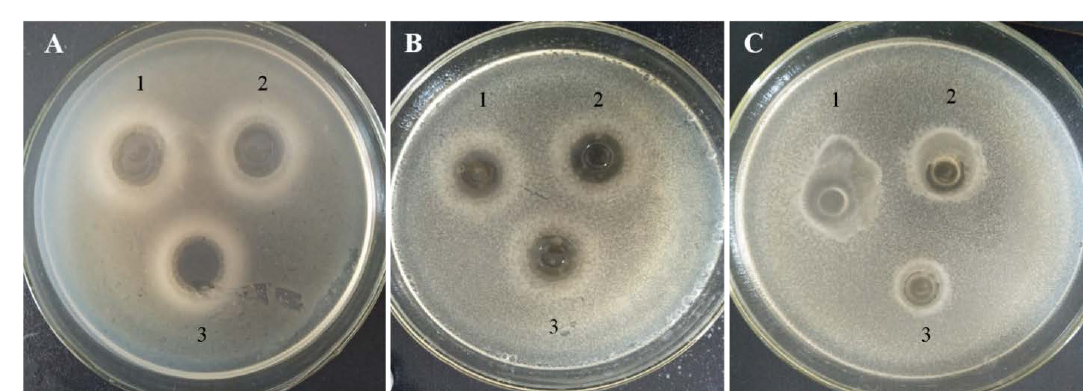
Data with different letters represent significant differences ( p < 0.05). 1 Antimicrobial activities: diameter of inhibition zones (mm); values expressed as means ± SD ( n = 3).